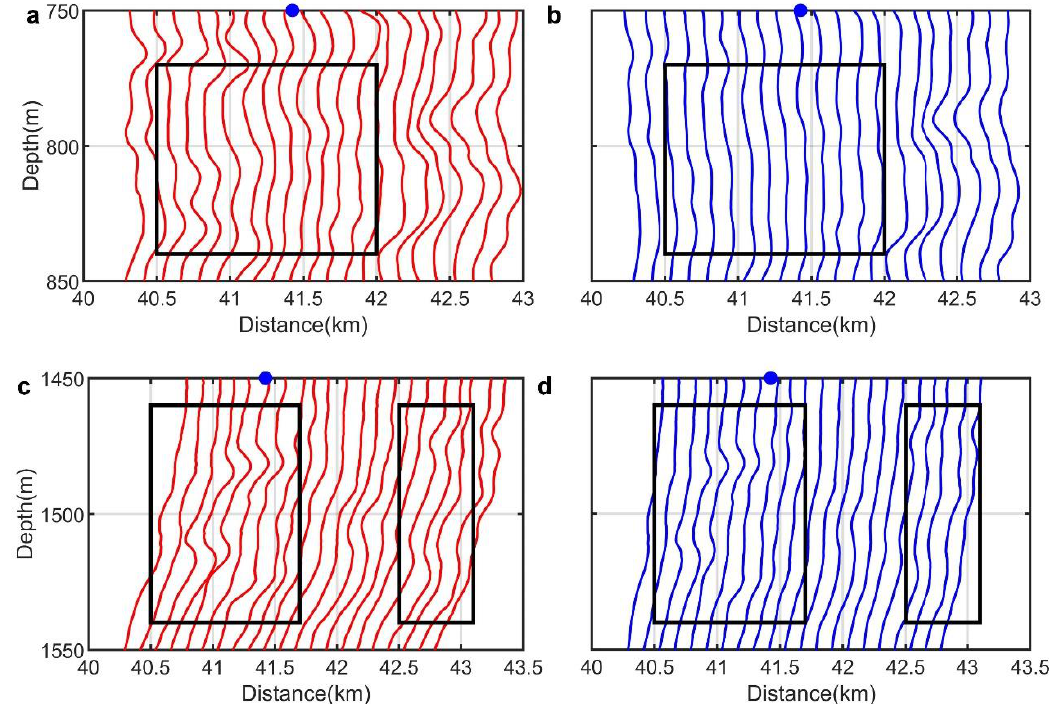
Figure 9. ( a ) Temperature and ( b ) salinity profiles at the top edge of the meddy from inverted sections. ( c , d ) as for panels ( a , b ) but at the bottom edge of the meddy. The temperature/salinity is horizontally averaged every ~120 m (20 CMPs), so that random wiggles introduced by the seismic source signature are smoothed out. Potential signs of staircases are circled by black rectangles. The blue dots represent the location of CTD cast 37. The temperature/salinity ranges from the CTD 37 cast are within the 95% CI of those from the seismic inversion.